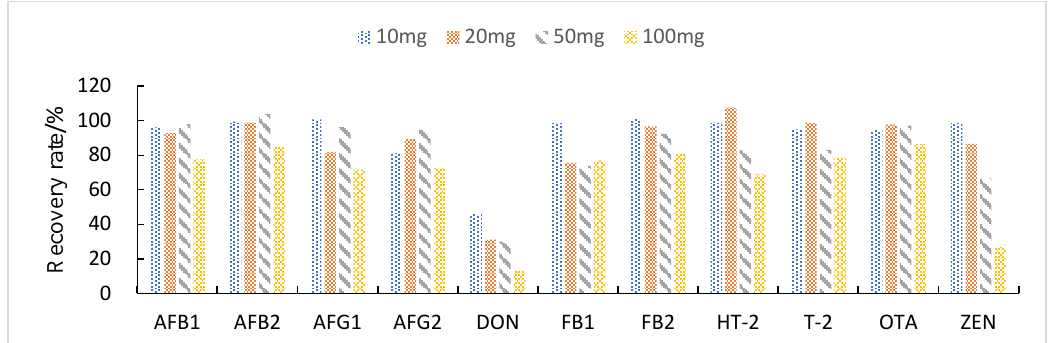
Figure 4. Effect of different BONDESIL-SI additions on the recovery of 11 fungal toxins.